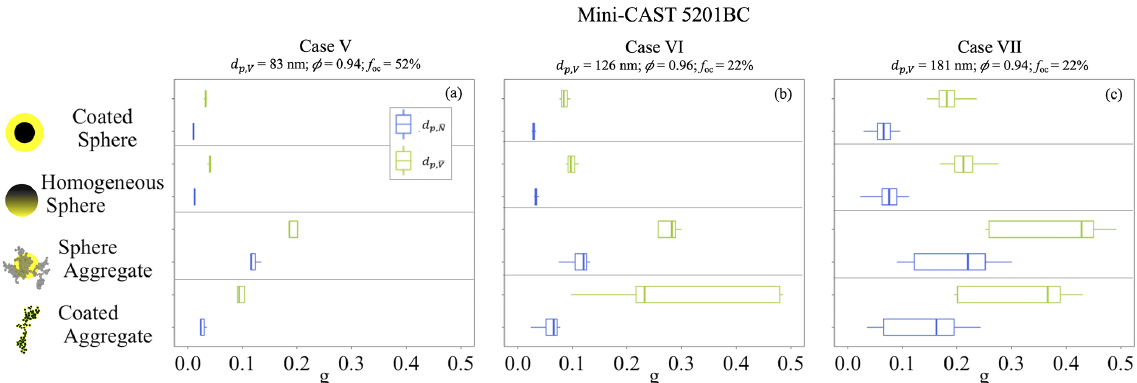
Figure 12. The BC mass absorption cross-section (MAC BC ) is modelled using the four representations of coated BC, i.e. “coated sphere”, “homogeneously mixed sphere”, “coated aggregate”, and “aggregate and sphere”. The results are shown for E2 cases V–VII: mini- = 83nm (a) , miniCAST 5201BC d = 126nm (b) , and miniCAST 5203C d = 181nm (c) CAST 5201BC d p ,V p ,V p ,V